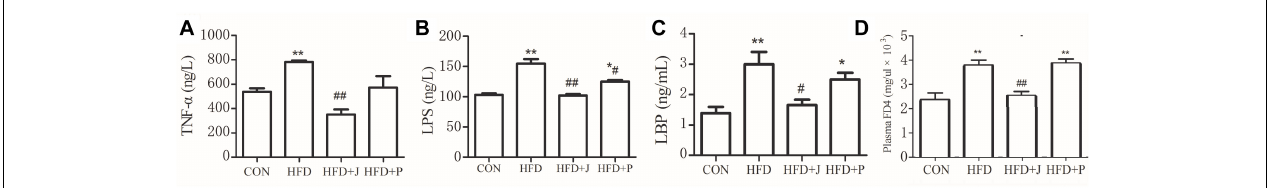
FIGURE 4 | Effects of Lactobacillus jensenii IgA-21 and Pediococcus acidilactici FS-1 on chronic inflammation (serum TNF- α , A ), endotoxemia (B) , LBP (C) and mucosal barrier (FD4) (D) in high fat diet fed mice. All data are presented as mean ± SD ( n = 8). ∗ P < 0.05, ∗∗ P < 0.01 (HFD versus CON); # p < 0.05, ## p < 0.01 (bacterial treatment versus HFD). Comparisons were made with one-way ANOVA followed by Tukey’s multicomparison test. CON, control group; HFD, high-fat diet group; HFD + J, high-fat diet group treated with Lactobacillus jensenii IgA-21; HFD + P, high-fat diet group treated with Pediococcus acidilactici FS1. FD4, Fluorescein isothiocyanate-labeled 4.4-kDa dextran; LBP, lipopolysaccharide-binding protein; LPS, lipopolysaccharide; TNF- α , tumor necrosis factor α